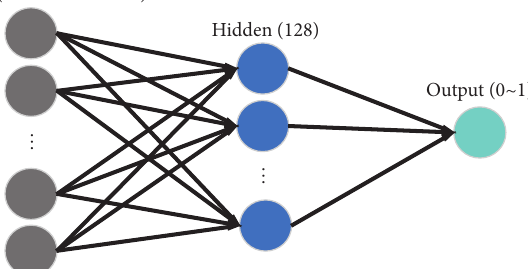
Figure 7: Data generation structure and multiple learning modules. Table 2: Generator network algorithm.